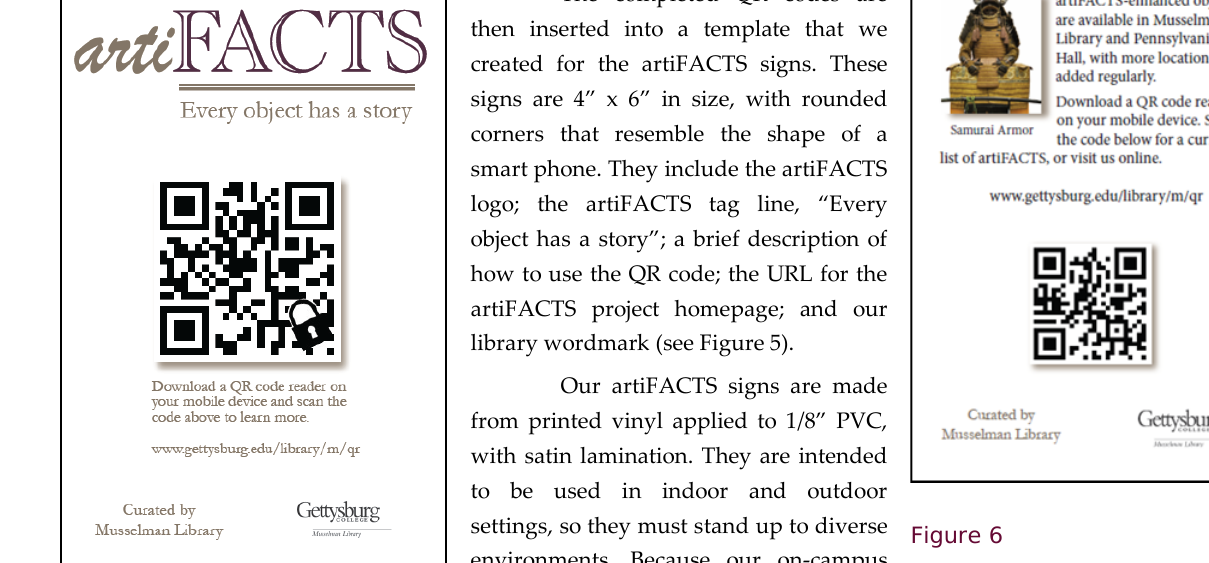
The rack card promotes the artiFACTS project at various high-traffic campus